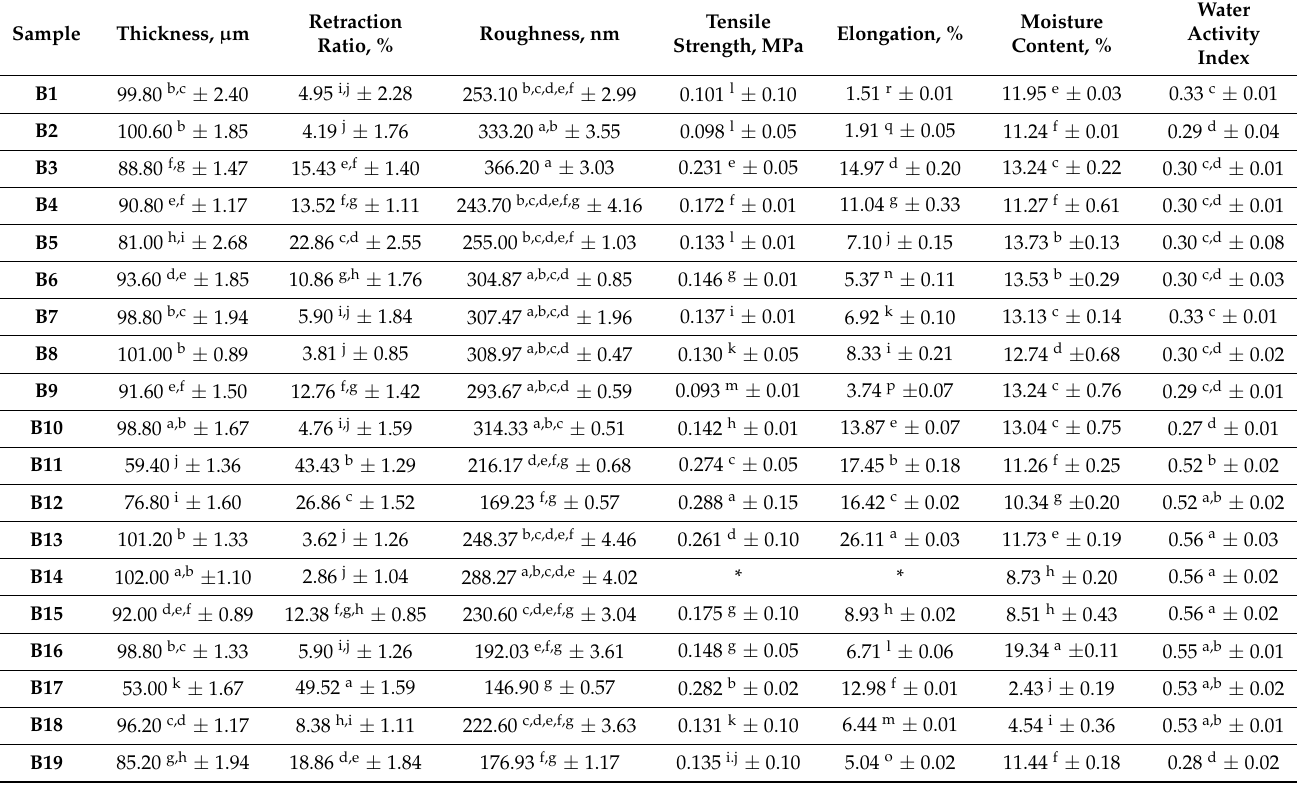
Table 3. Structural characteristics of the developed films with essential oils